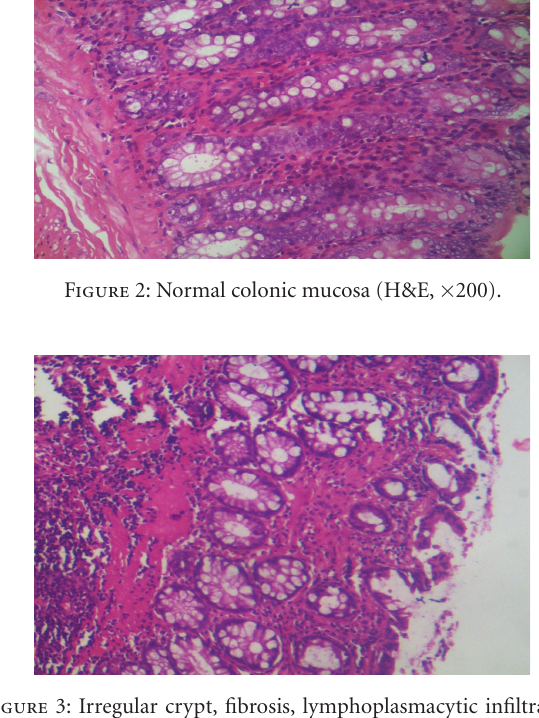
Figure 3: Irregular crypt, fibrosis, lymphoplasmacytic infiltration (H&E, ×